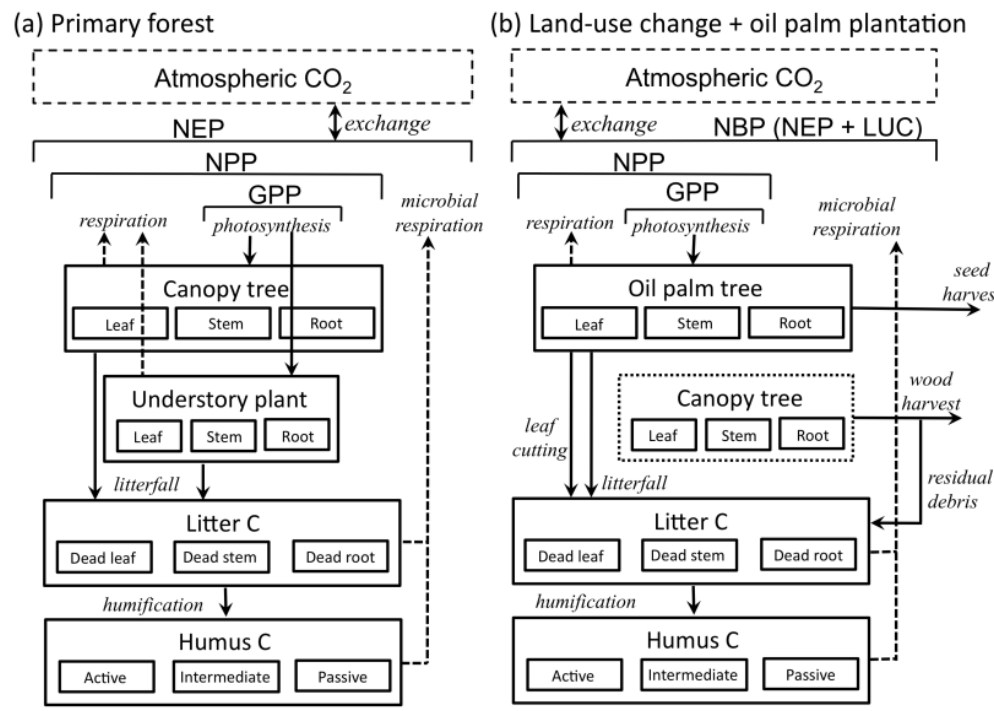
Fig. 2. An overview of the VISIT model for (a) primary forest and (b) land-use change (LUC) from forest to oil palm plantation. The C flux among the compartments and the atmosphere represent net ecosystem production (NEP), net primary production (NPP) and gross primary production (GPP); net biome production (NBP) consists of NEP and carbon flux from LUC. Table 1. VISIT model parameters for the primary forest (dry evergreen forest and rainforest) and oil palm plantation. Parameters Unit Forest Oil palm plantation Maximum photosynthetic